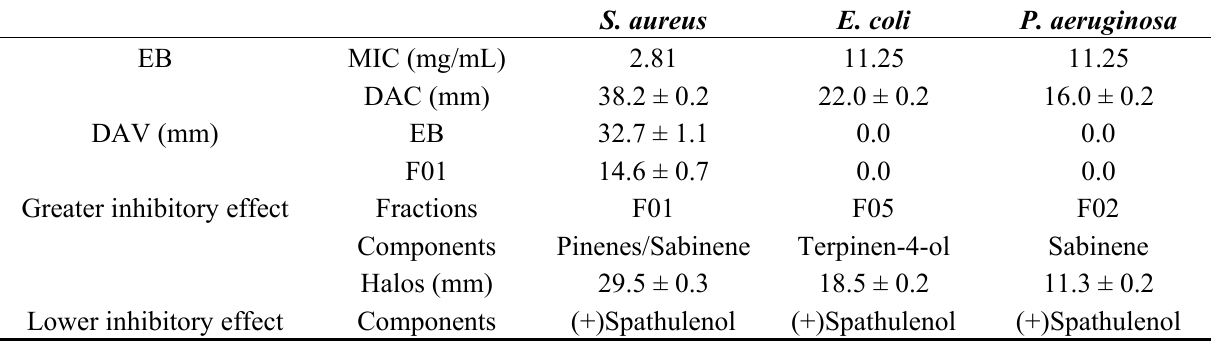
Table 9. Shows the inhibitory effects greater and lower in oil